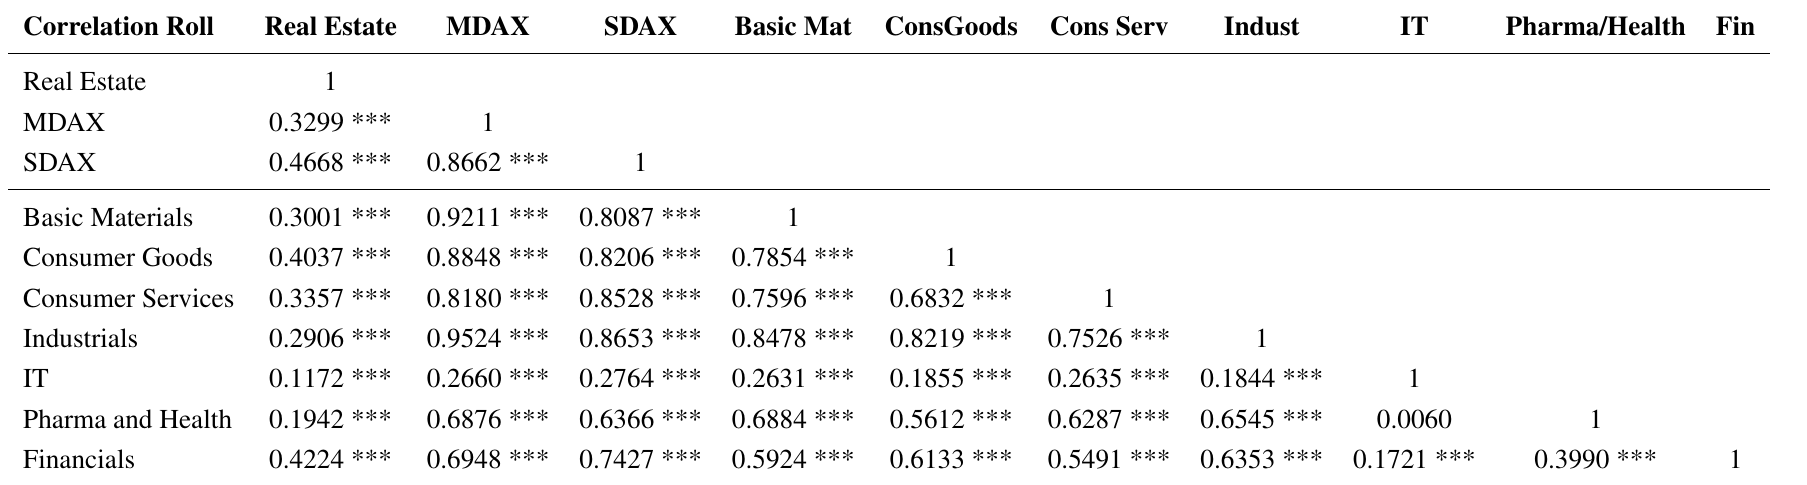
Table A1. Skewness in trading volume correlations between several asset